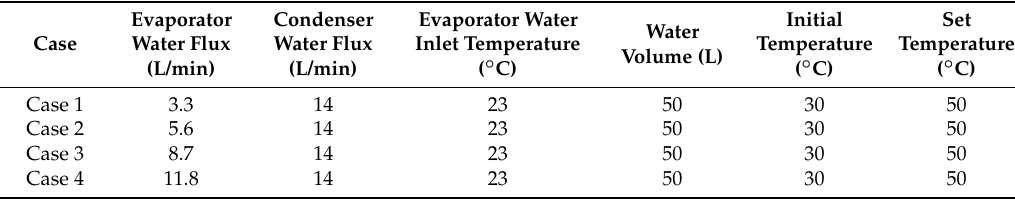
Table 2. System parameters at different evaporator water Table 2 System parameters at different evaporator water fluxes.